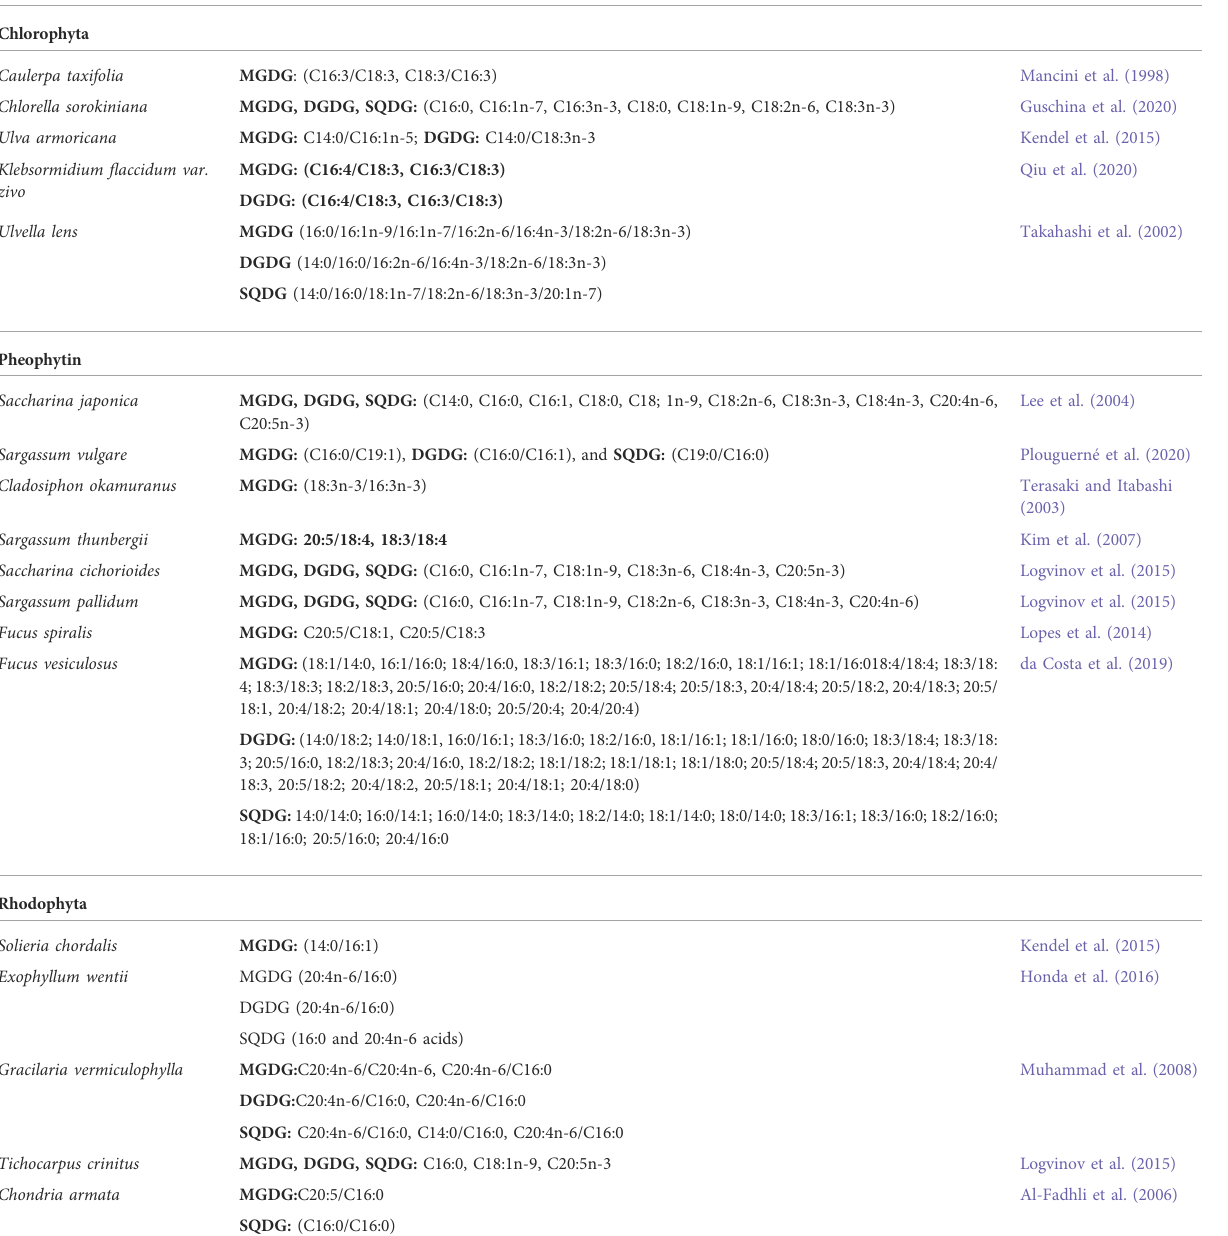
TABLE 1 Fatty acids of glyceroglycolipids in several marine algae